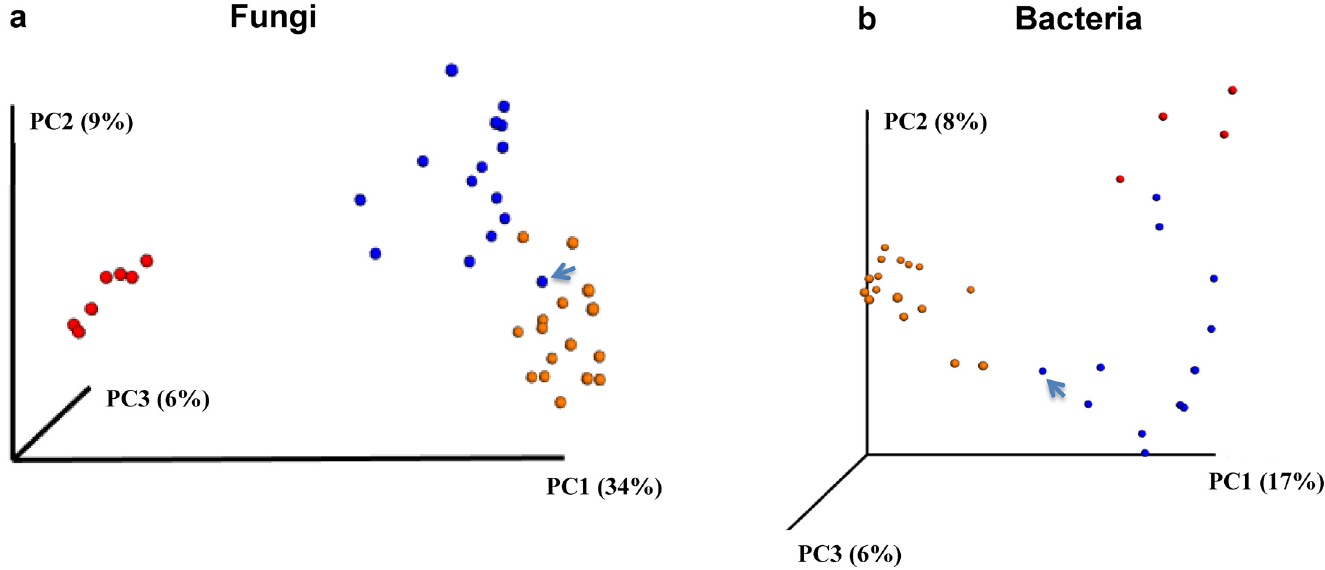
Fig 3. PCoA of Binary-Jaccard dissimilarities of microbial communities of fresh tea leaf (red), raw (blue) and ripened (orange) Pu-erh samples. The oldest raw Pu-erh sample (A6, 28 years old), indicated by an arrow in both PCoA analyses, is more similar to ripened Pu-erh than to other raw Pu-erh samples.